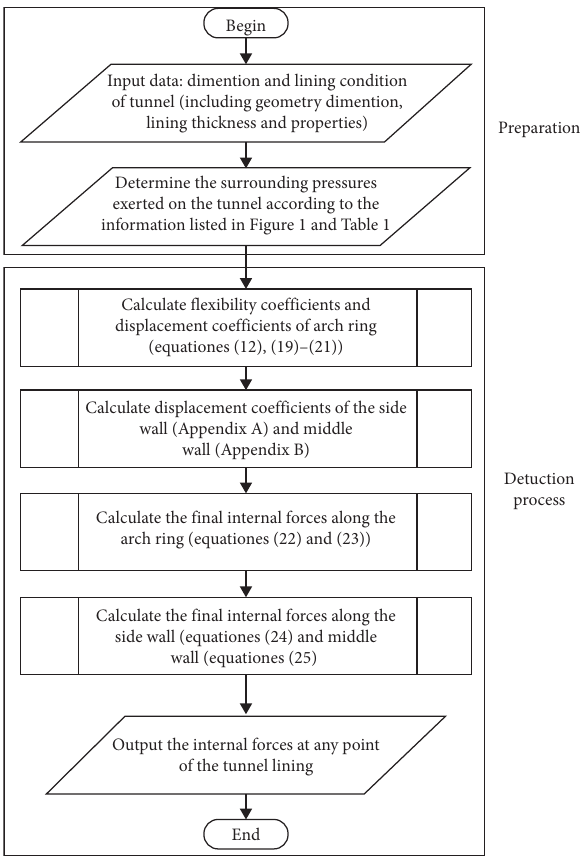
Figure 7: The flow chart of the determining Table 3: The main physical and mechanical properties of the grade Table 4: Input information in the analytical solutions. V surrounding rock [10].